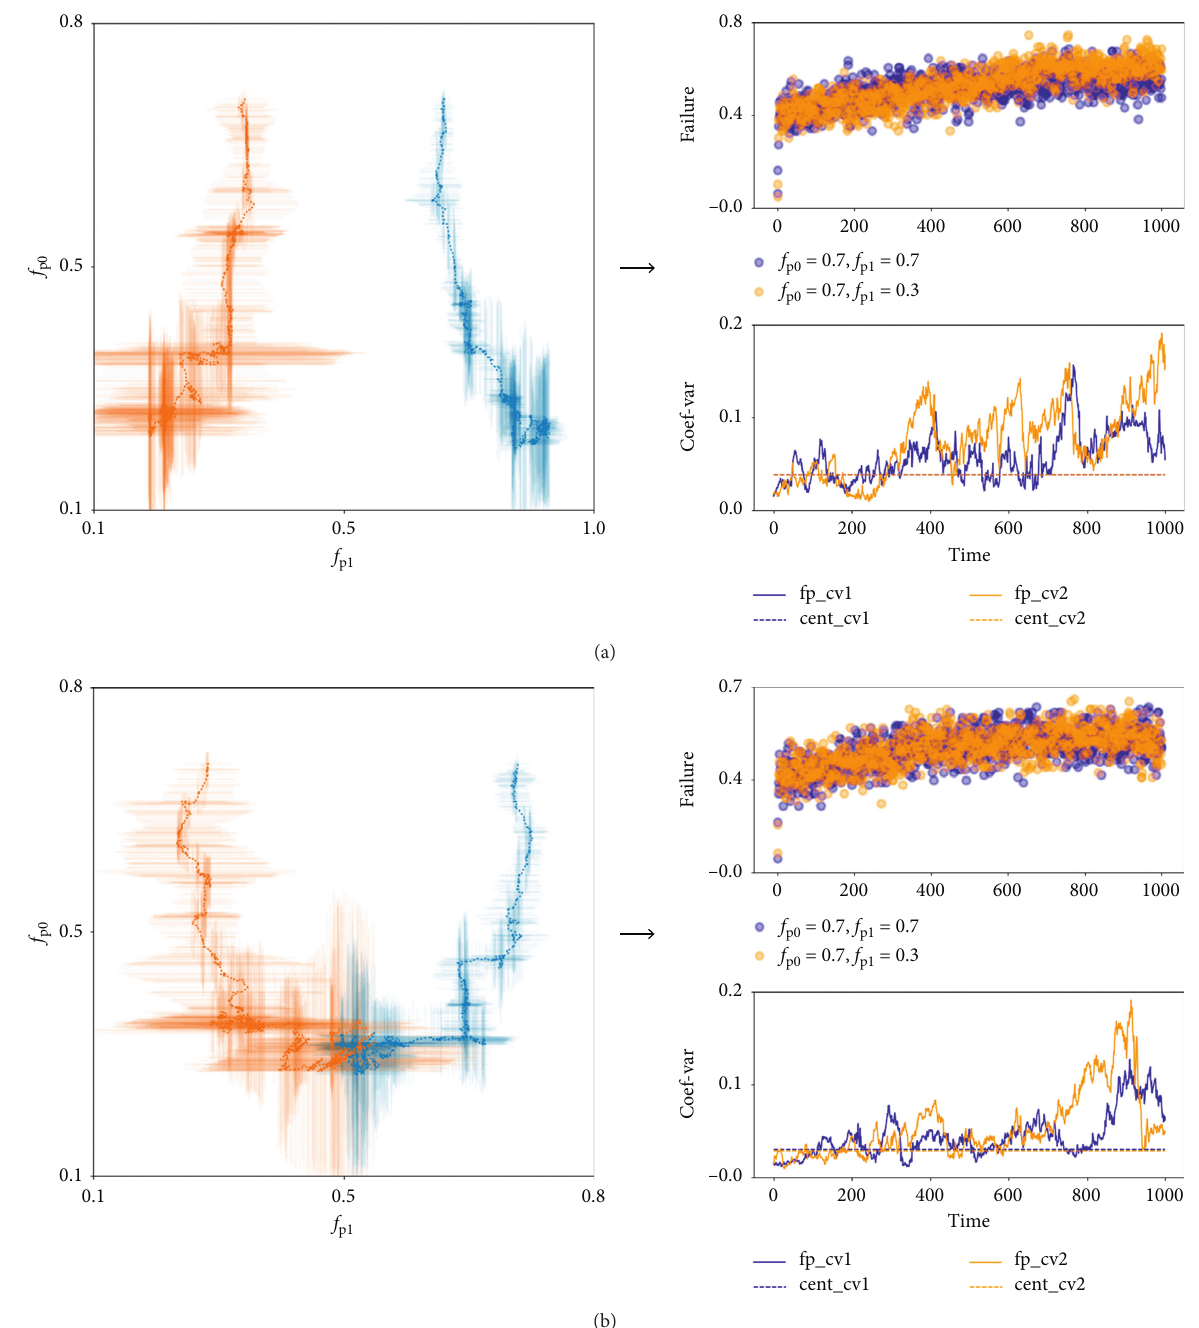
Figure 7: Described protection dynamics against systemic risk with the different initial condition of the strategies. At each section � vertical axis, f � horizontal axis, dashed (divergent and convergent), the plot of the left side shows its evolutionary trajectory ( f p0 p1 � 0.3, f � 0.7 lines � coefficient of variation, dots � averaged value of the trait according to time step from the initial points; oranges: f p0 p1 � 0.7, f � 0.7). The plot of the upper right side represents the failure (vertical axis) according to time step (horizontal axis) and blues: f p0 p1 � 0.3, f � 0.7, blue: f � 0.7, f � 0.7). The plot of the lower right side shows with two different initial points of the strategies (orange: f p0 p1 p0 p1 values separately and their centrality (C � dotted lines) which is the two simulations’ coefficients of variation (cv � dashed lines) of the f p applied from the initialized random network property. Initialized parameters of the simulation are nodes n � 100, connection p � 0.9, capital c � 1, f � 0.1, s � 100, p � 1, c � 0.5, p � 0.9, p � 0.05, μ � 0.0, σ � 0.02, p � 0.001, p � 0.1, and t � m p , max p , 1/2 r e n l